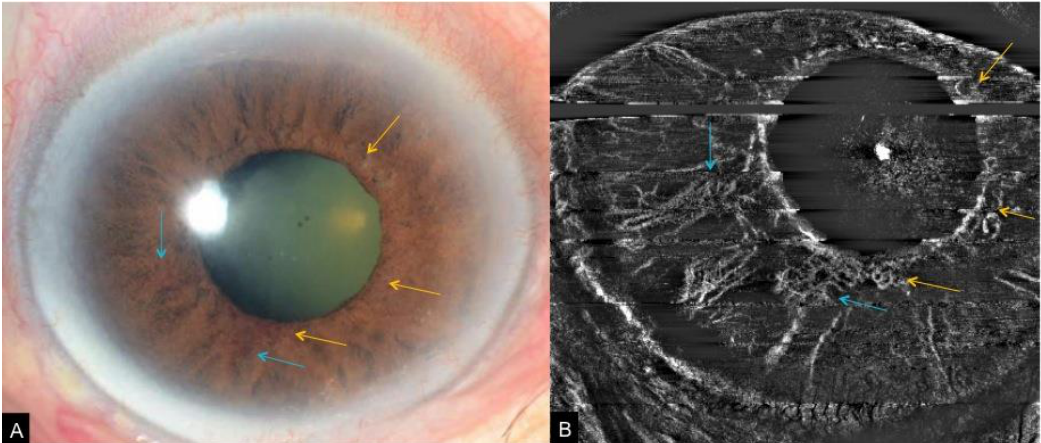
Figure 9. A case of iris neovascularization secondary to ocular ischemic syndrome. Slit lamp photograph ( A ) corresponding OCTA of the iris ( B ) showing fine new vessels at the pupillary border (yellow arrows) and slightly larger new vessels on the anterior surface of the iris (blue arrows).